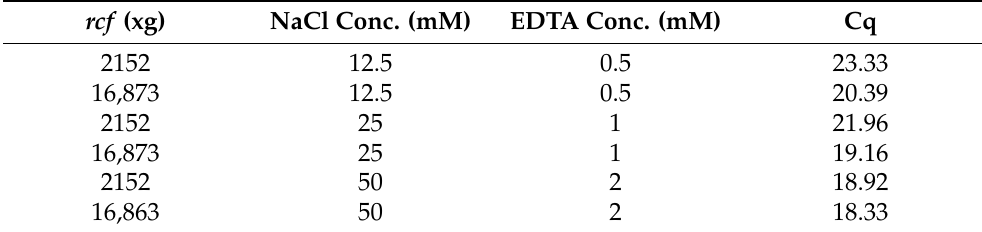
Table 2. Real-time PCR results from squish buffer formulations and centrifugation speeds; all samples are ratios of 1 H. armigera leg: 20 H. zea legs.